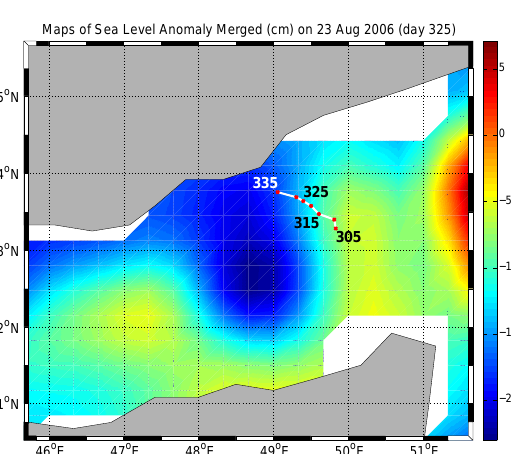
Figure 9: Vertical sections of temperature (in o C , left) and of salinity (right) along float 2900392 trajectory for year 1.